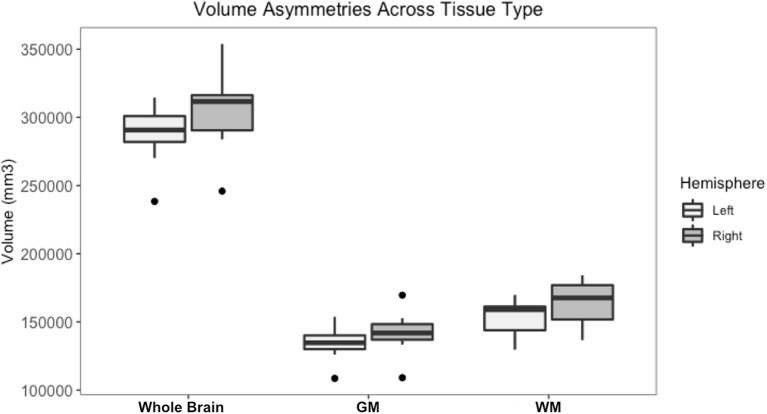
Box and whisker plots of right and left hemisphere volumes of the whole brain gray matter (GM) and white matter (WM). All subjects had higher right-sided volumes for all tissue types however an independent t-test found no statistically significant difference between right and left sides for whole brain (p-value = 0.75), GM (p-value = 0.212) or WM (p-value = 0.104, significance considered present with a p-value < 0.05).